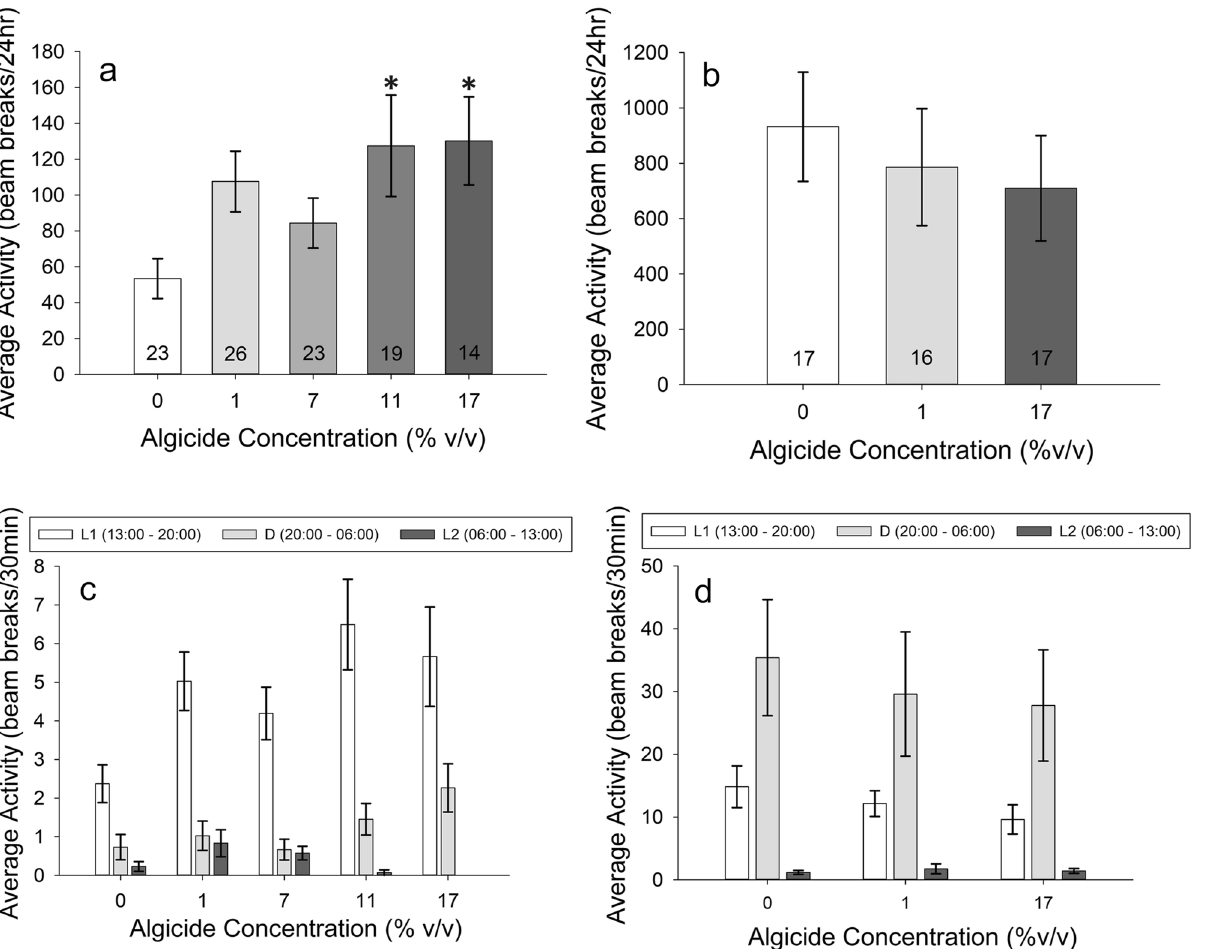
Figure 4. Activity levels of Callinectes sapidus ; numbers on the bars represent sample size. Row 1: Activity level of C. sapidus zoeae ( a ) and megalopae ( b ) as a function of algicide concentration over a 24-h period. Animals were first pre-exposed to the listed concentrations of algicide for 24 h, then placed into tubes of algicide-free water for activity measurements over the subsequent 24 h. Row 2: Data from ( a ) and ( b ) broken down into activity per 30 min and separated by time of day for zoeae ( c ) and megalopae ( d ). Notice the scale differences among the graphs. (* p <